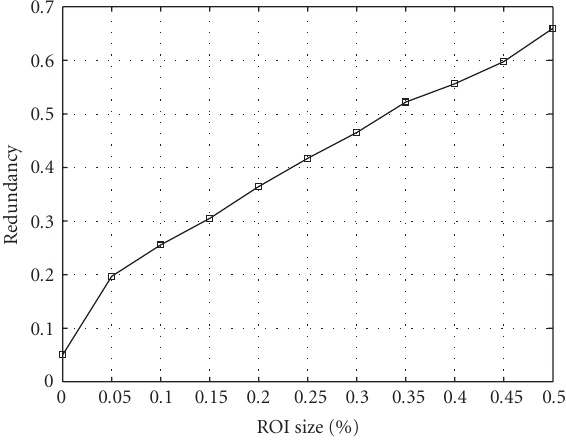
Figure 5: Relationship between ROI size and resulting